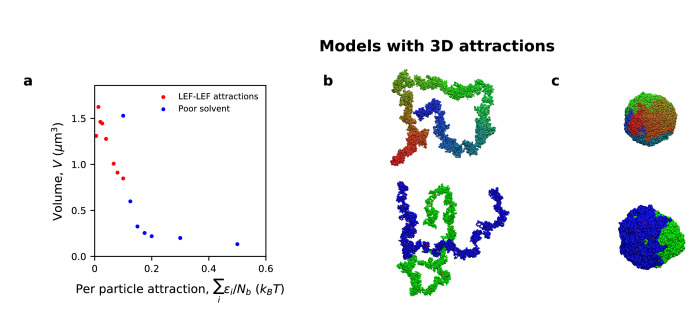
Defective compaction and segregation with 3D attractive interactions.(a) Volumetric compaction plotted as a function of average attraction energy per monomer, for simulations with LEF-LEF attractive interactions (red) and attractive interactions between all monomers (i.e., poor solvent conditions; blue). (b) Simulation images of chromosome compaction (top) and sister chromatid resolution (bottom) in simulations with LEF-LEF attractions. (c) Simulations images of chromosome compaction (top) and sister chromatid resolution (bottom) in simulations with poor solvent.